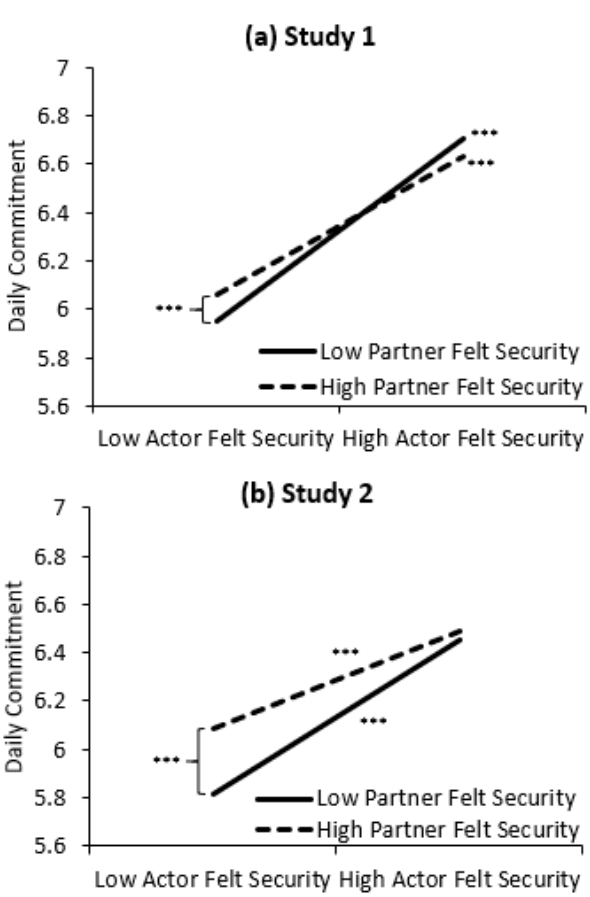
Figure 1. The e ff ects of actor and partner felt security on daily commitment in ( a ) Study 1 and ( b ) Study Figure 1. The effects of actor and partner felt security on daily commitment in (a) Study 1 and (b) 2. Note . Low and high levels of actor and partner felt security represent 1 SD below and above the Study 2. mean. The simple e ff ects of the slopes and contrasts are marked *** p ≤